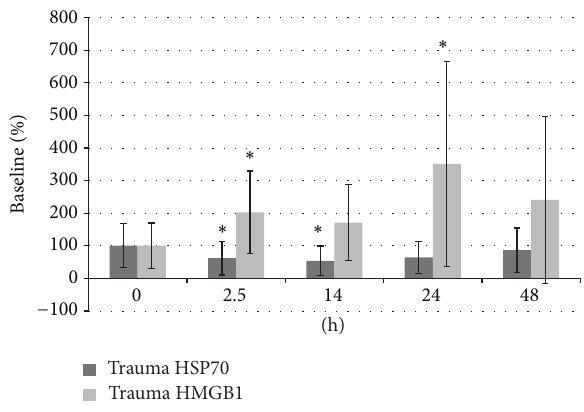
Figure 3: HMGB1 & HSP70 serum concentrations, ∗ = 𝑃 < 0.05 compared to baseline values and sham